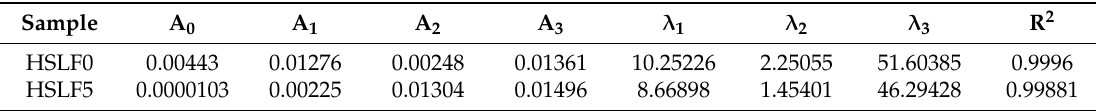
Figure 7. ( a ) Afterglow decay curve of HSLF5 and HSLF0. HSLF5, which is stimulated by heat flow, is labeled as HSLF5-Stimulate; ( b ) Heat-stimulated luminescence phenomenon of HSLF5 stimulated by the touch of a finger. Table 2. Fitting parameters of afterglow curves.